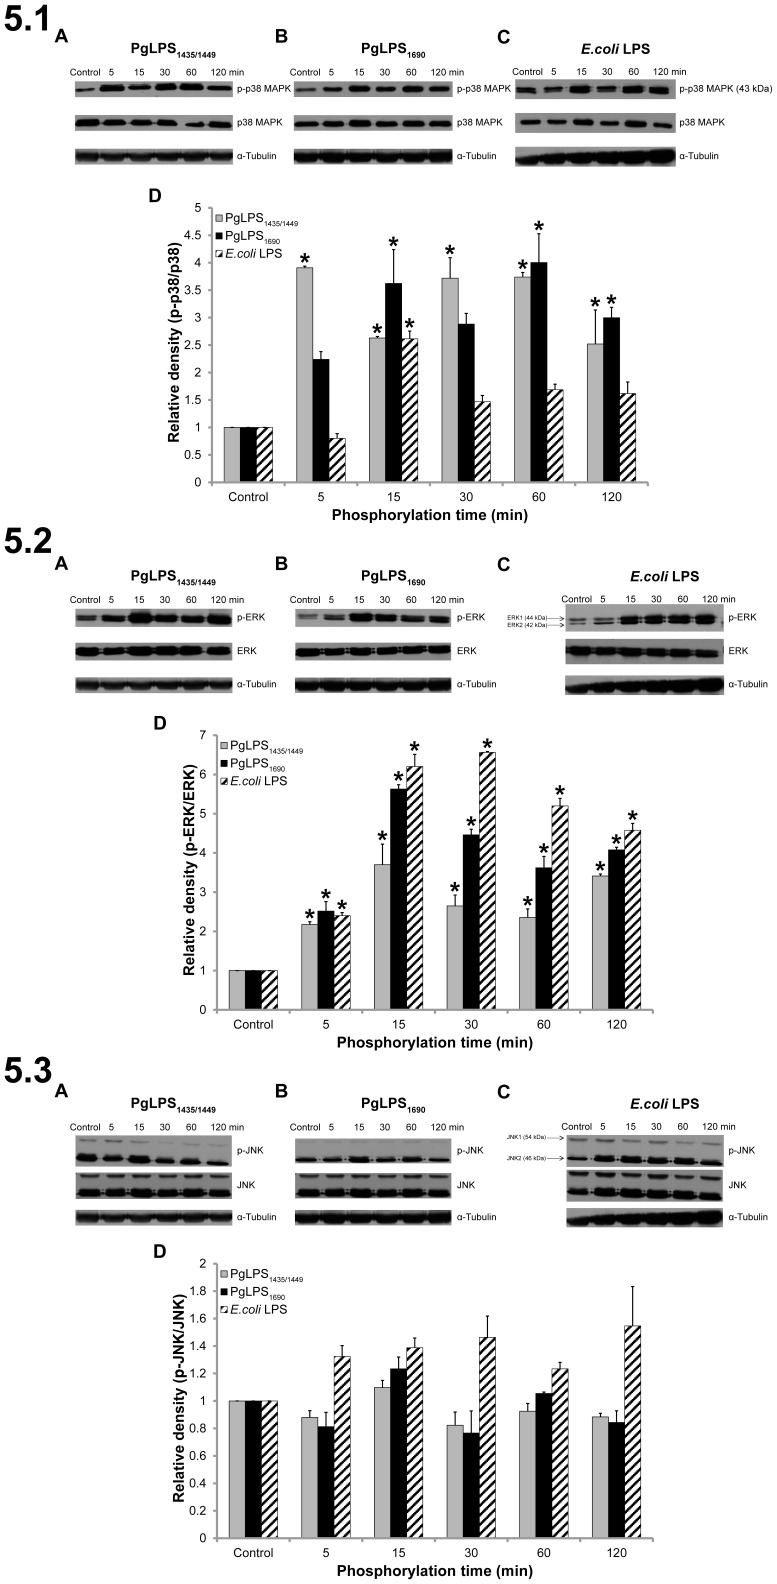

P. gingivalis (Pg) LPS (PgLPS) and E. coli LPS activated the MAPK pathway in HGFs.Kinetics of P38 mitogen activated protein kinase (P38 MAPK), extracellular signal-regulated kinase1/2(ERK1/2), and Stress-activated protein kinase/c-Jun NH2-terminal kinase (SAPK/JNK) phosphorylation in HGFs are shown in 5.1, 5.2 and 5.3, respectively. Cells were treated with PgLPS1435/1449 (A), PgLPS1690 (B) and E. coli LPS (C) at 1 µg/mL for the indicated period of time. Cell extracts were prepared and the levels of P38 MAPK, phospho-p38MAPK, ERK, phospho-ERK, JNK and phospho-JNK were determined by western blotting. Quantification of band intensities was performed by densitometry analysis using Image J software. The fold increase values of phospho-protiens of P38 MAPK (5.1D), ERK1/2 (5.2D) and SAPK/JNK (5.3D) as compared with the total protein are shown in the graphs (arbitrary units over control after normalization to the total protein). Equal loading was confirmed by stripping the immunoblot and re-probing it for α-Tubulin. The data shown here are from a representative experiment repeated three times with similar results. *Significant difference with a p-value <0.05 as compared with the controls without LPS treatment.